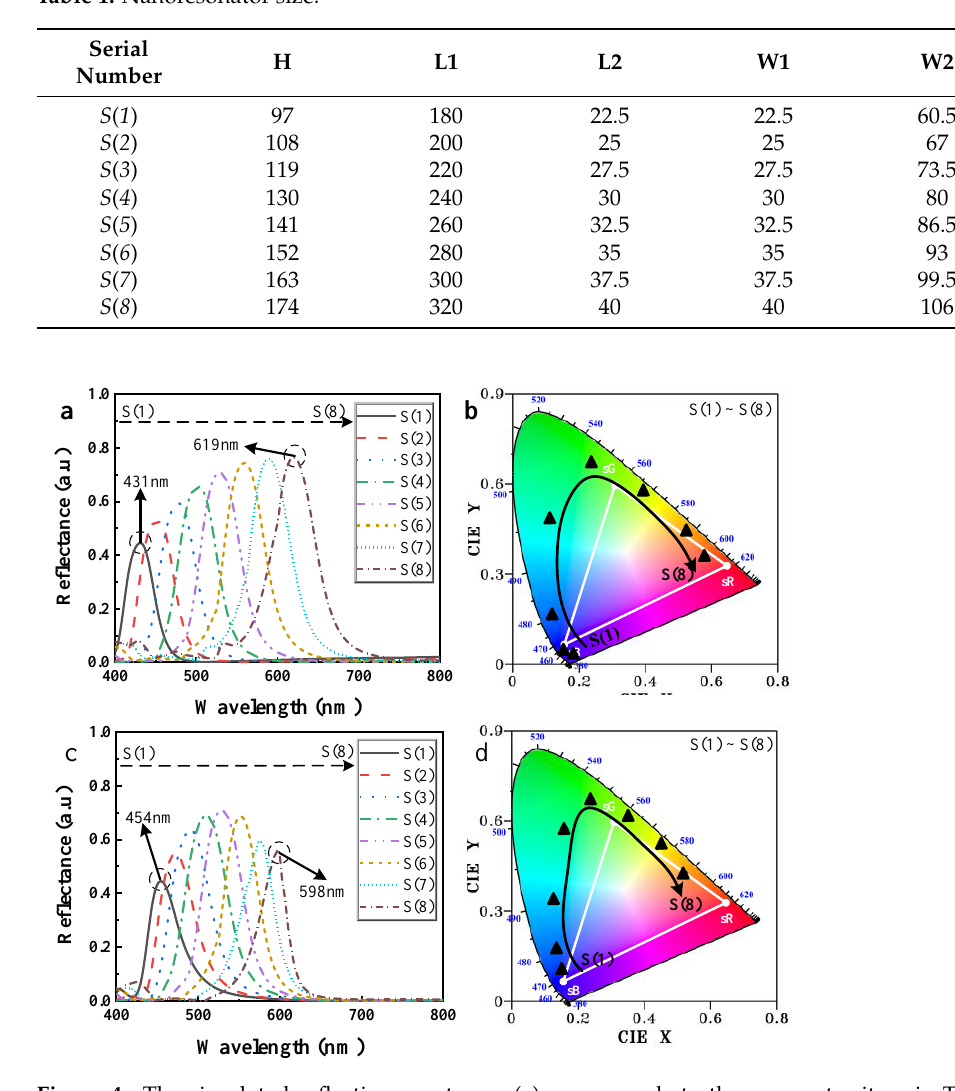
Figure 4. The simulated reflection spectrum: ( a ) corresponds to the parameter item in Table 1, ( c ) h = 141 nm and the other parameters correspond to the parameters in Table 1, and the CIE1931 chromaticity diagram corresponds to ( b , d ) S ( 1 )~ S ( 8 ).